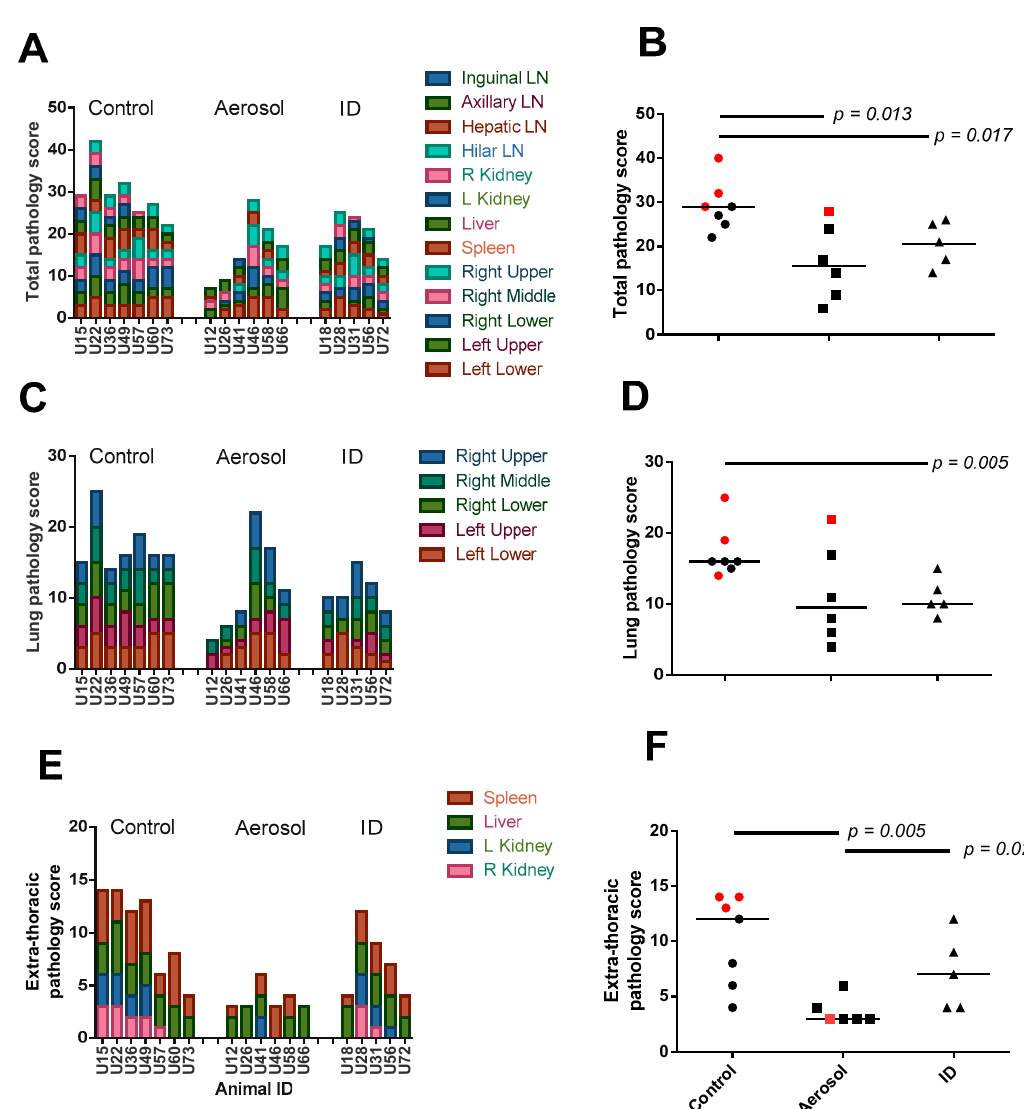
Figure 4. Gross-pathology assessed at necropsy. The occurrence and extent of tuberculous disease pathology were recorded at necropsy using a standardised scoring system. This approach was used to determine total pathology scores from a range of pulmonary and extra-pulmonary tissues ( A , B ), lung pathology derived from scores assessed in each lung lobe ( C , D ), and an extra-thoracic score comprised of scores recorded from tissues typically associated with bacterial dissemination ( E , F ). Plots A , C and E show scores recorded from specific tissues in each individual animal, whereas plots B , D and F display summed tissue scores with group median values indicated. Animals that met humane end-point criteria are indicated with red data points. Significant differences between groups determined by Mann–Whitney U-test are shown.